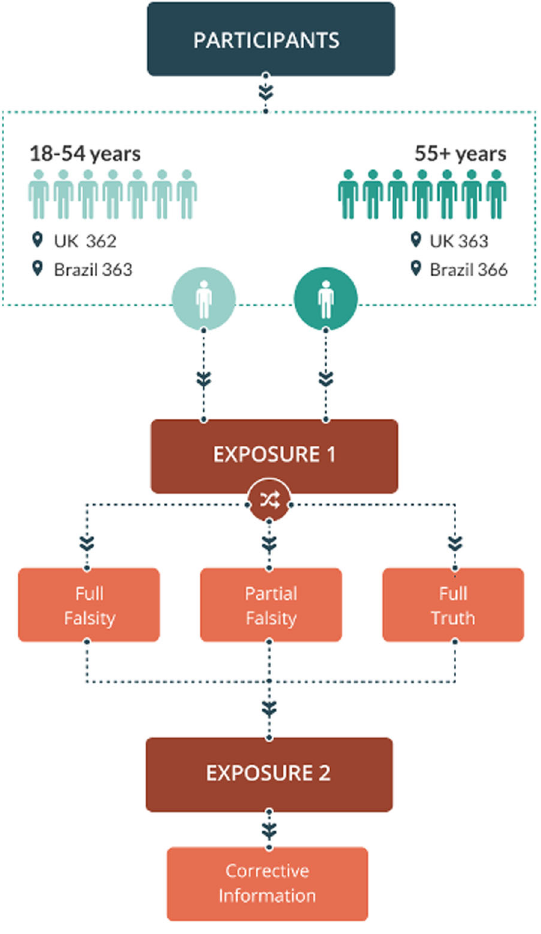
Fig. 1 Study design depicting exposures and randomized assignment of participants to (mis)information types. Experiments were based on a